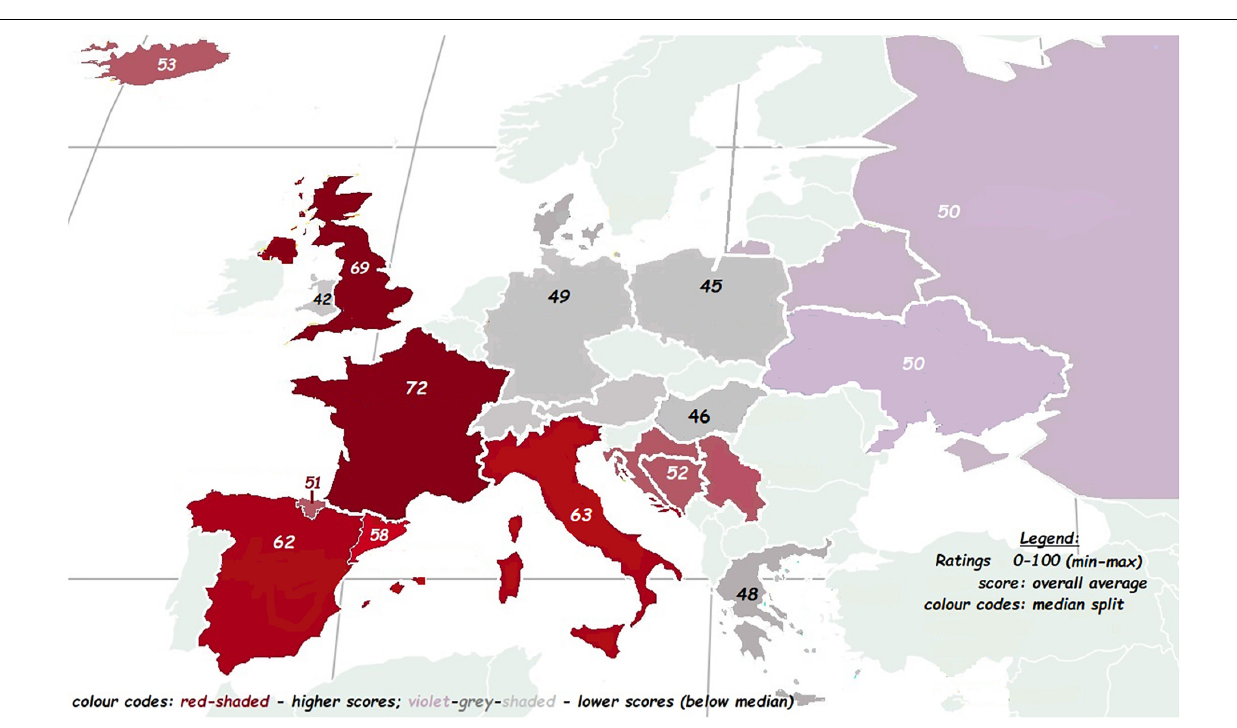
On the Softness/Sweetness scale, the highest languages were French (75), English (65.3) and Italian (65.3). The lowest scores were German (25.4), Welsh (38), and Danish